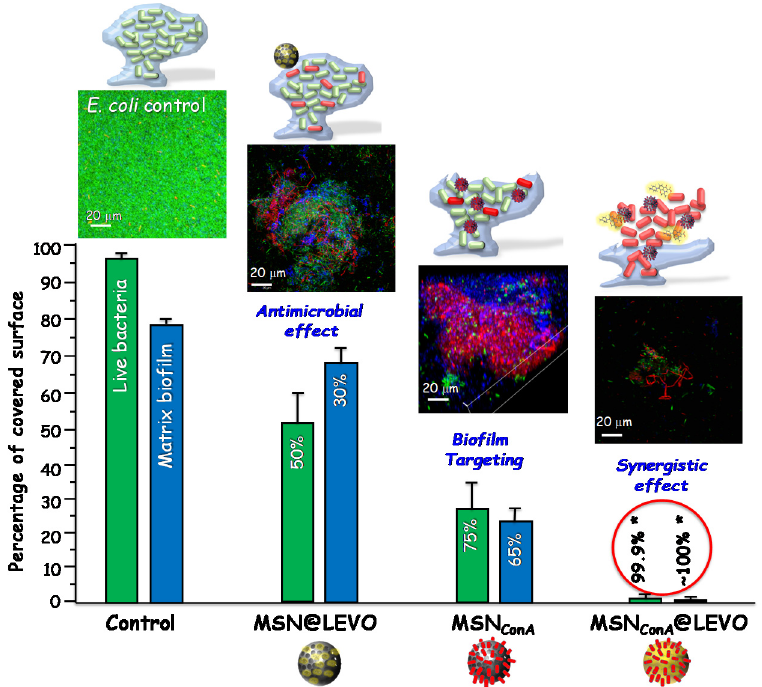
Figure 8. Antimicrobial activity of levofloxacin loaded and Concanavalin A functionalized MSNs against E. coli biofilm. The histogram represents the reduction in percentage of covered surface of live bacteria (green bars) and mucopolysaccharide matrix (blue bars), calculated from the confocal microscopy images (top). The images were obtained after exposure of a preformed biofilm to the different nanosystems during 90 min of incubation. Live bacteria are stained in green, dead bacteria in red, and the protective matrix biofilm in blue. A synergistic effect is achieved when the MSNs are loaded with levofloxacin and functionalized with ConA which acts as targeting agent for the mucopolysaccaride matrix and allows the release of the antibiotics inside the biofilm. Adapted with permission from Martínez-Carmona et al. [111], Acta Biomater., published by Elsevier, 2019.